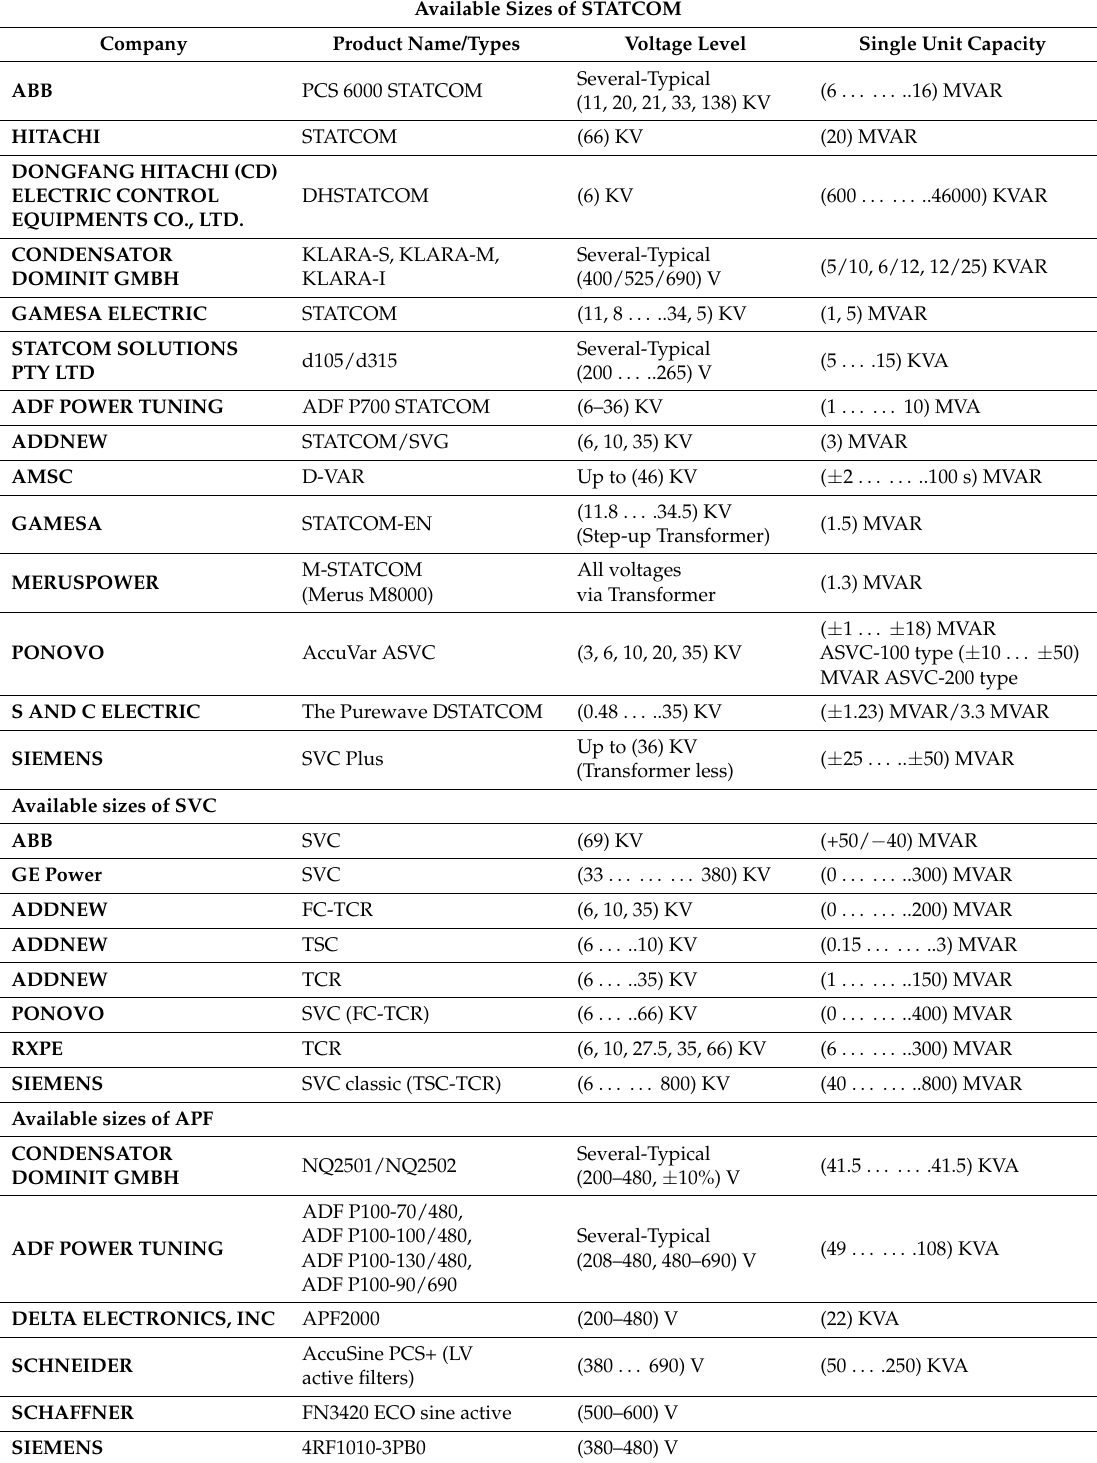
Table 10. STATCOMs, SVCs and APFs technology products for high power applications available in the